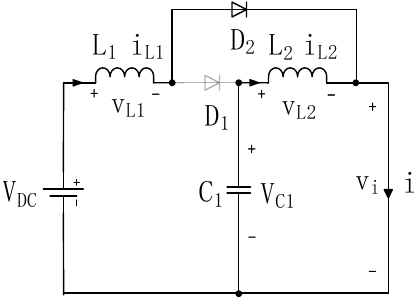
Figure 2. The equivalent circuit of the half quasi-Z-source inverter in the shoot-through zero state.